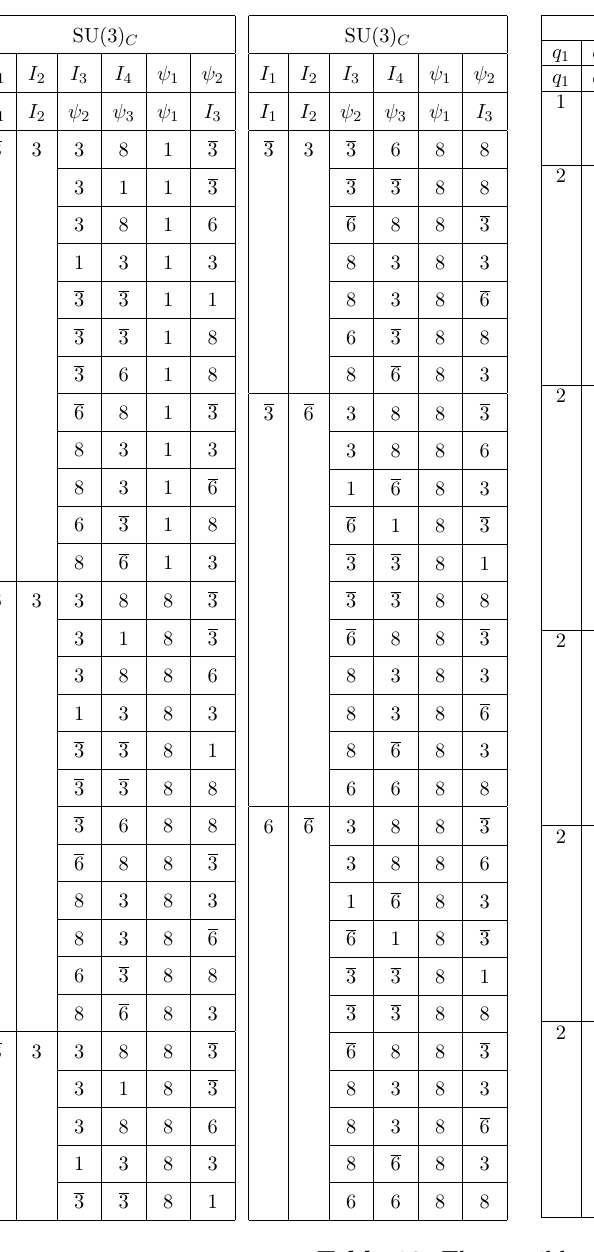
Table 18 . The possible quantum numbers of the fields in Topology-L-15 and